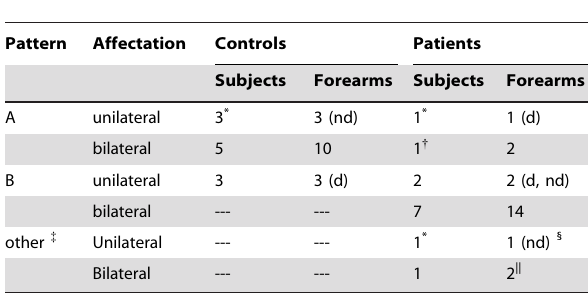
(0.67 6 0.23, n =19, vs 0.34 6 0.10, n= 16; p , 0.001). Exercise total Pi/PCr ratio values of pattern A forearms showed inverse and hand length (r = 2 0.54, p= 0.017). Pattern B forearms did not Table 2. Occurrence of Pi peak splitting patterns in the studied population.